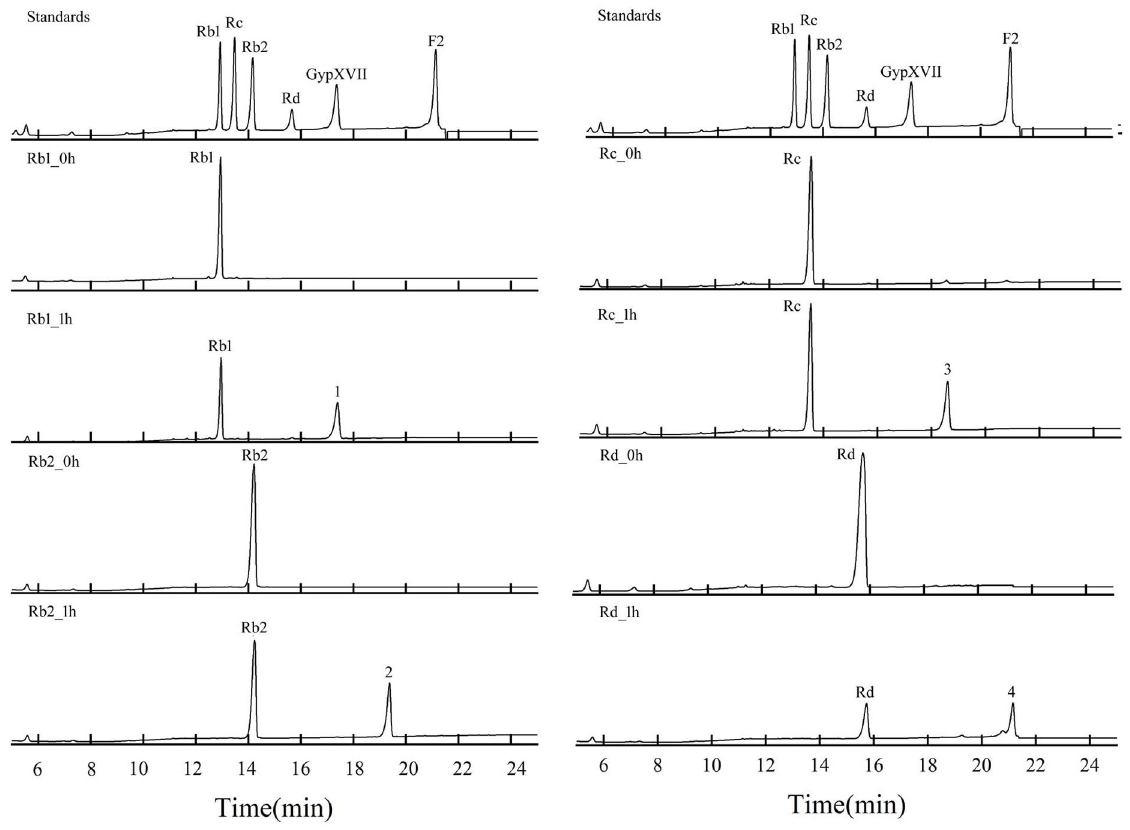
Fig. 5 HPLC analysis of ginsenoside Rb1, Rb2, Rc and Rd during biotransformation process by using BcelFp. Ginsenoside standards were indicated on the peaks. Numbers were used to indicate the product